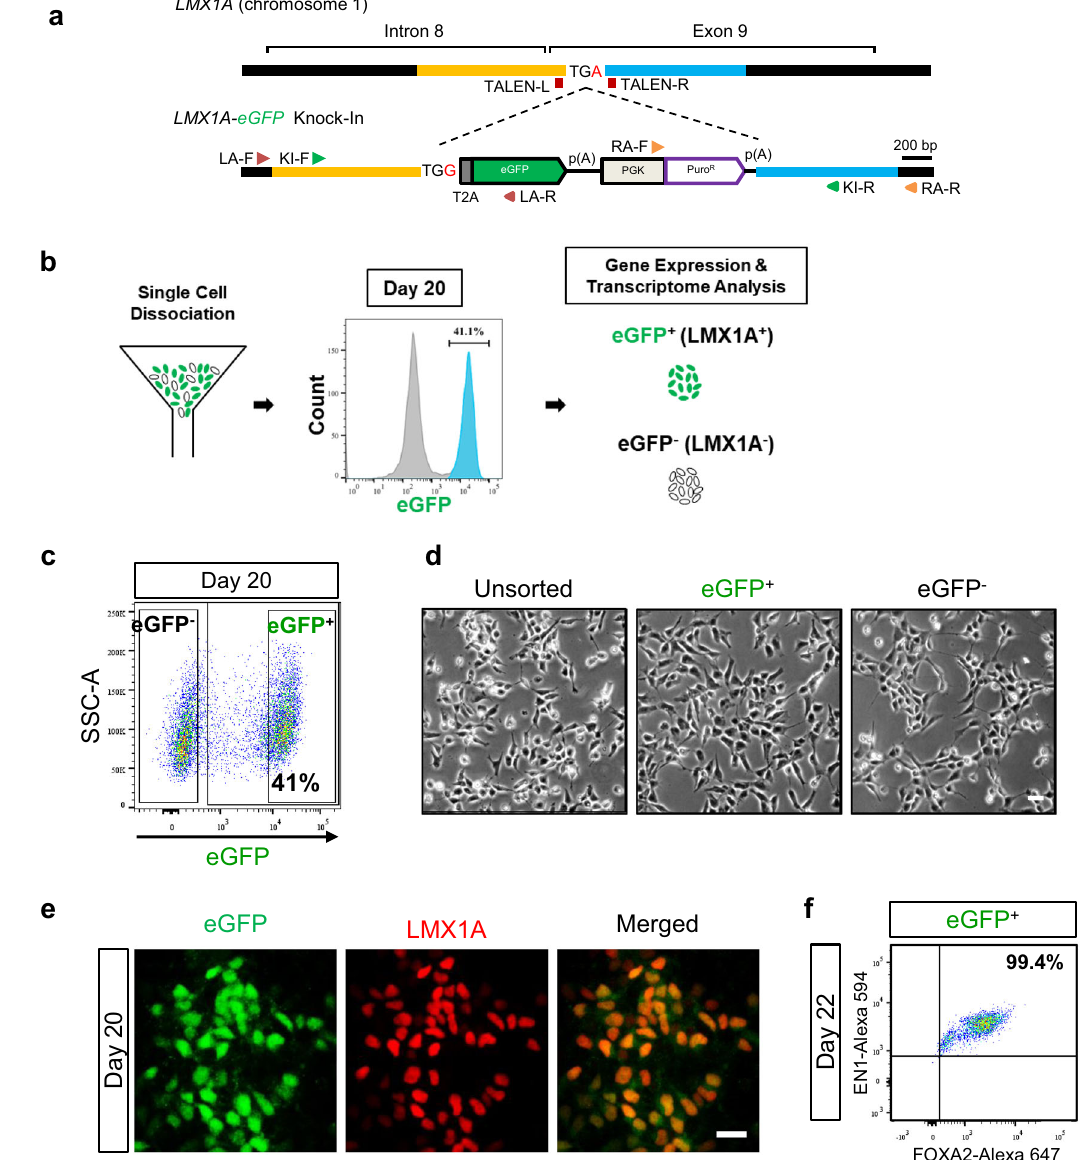
Fig. 1 FACS isolation of eGFP + cells. a Schematic of the generation of the LMX1A-eGFP hESC reporter line. Biallelic insertion of eGFP into exon 9 of the LMX1A locus was performed using a nonstop mutation (TGA > TGG) in H9 hESCs and acted as a reporter for endogenous LMX1A protein expression. b Schematic overview of isolation and transcriptome analysis of eGFP + cells on D20. c The eGFP + fraction was determined according to fl uorescence intensity in the eGFP channel using a 488-nm laser for excitation. d Bright- fi eld images of unsorted, eGFP + , and eGFP − cells at 6 h after cells were replated. e eGFP + cells (green) also expressed LMX1A (red). f Flow cytometry analysis of EN1 and FOXA2 expression in eGFP + cells on D22, with three biological replicates. Scale bars, 25 μ